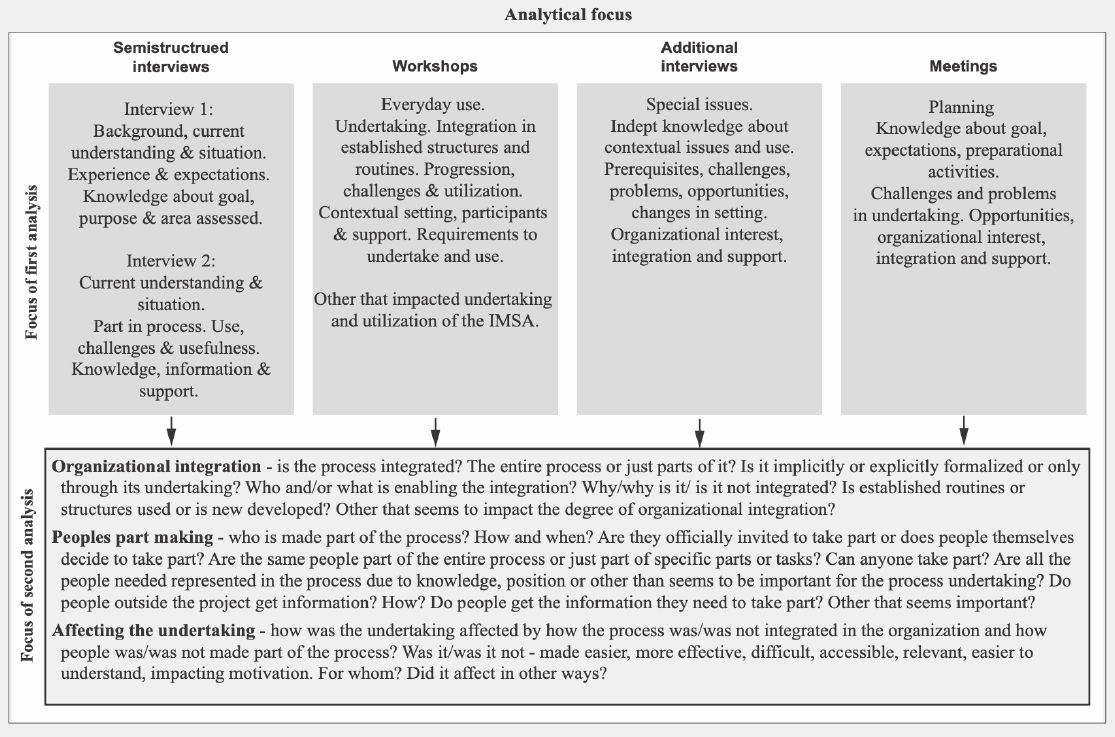
Fig. 5. The analytical focus of interviews, workshops and